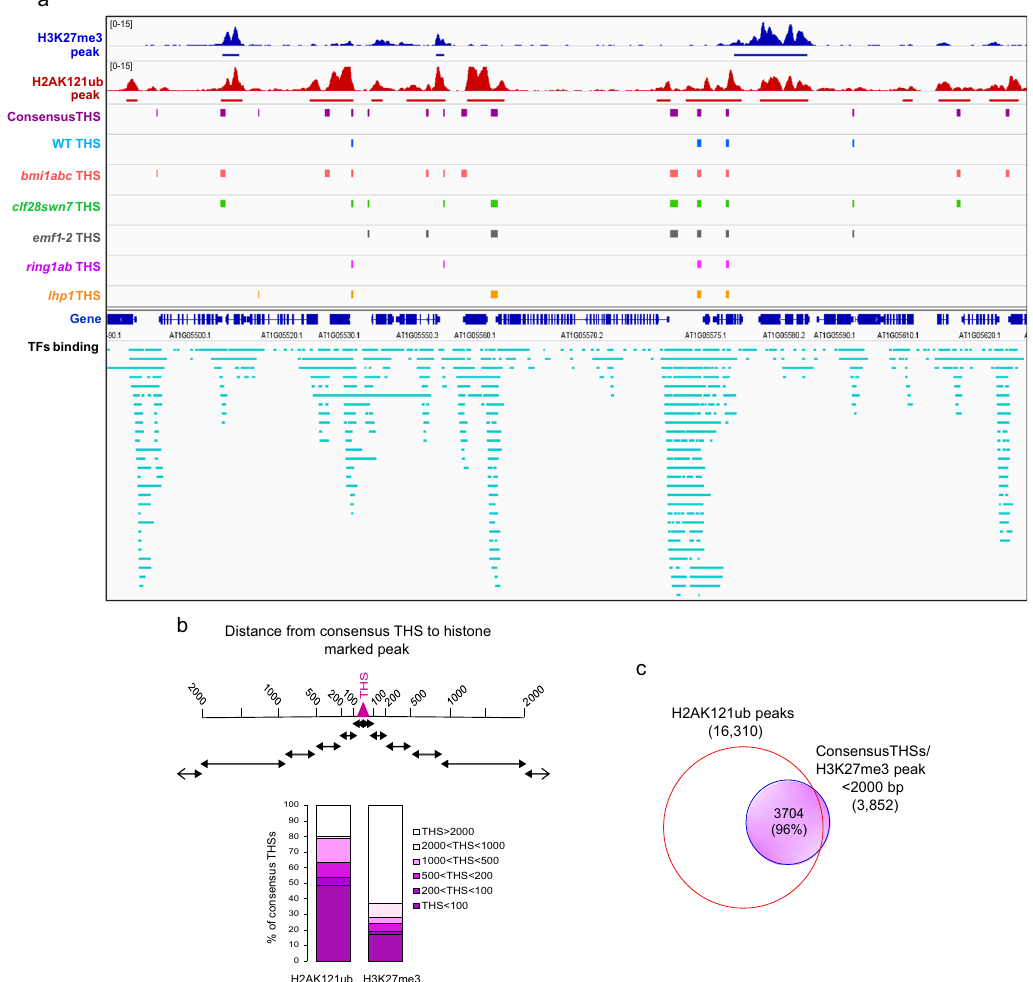
Fig. 2 H2AK121 monoubiquitination hallmarks hotspots for transcriptional regulation. a Screenshots showing distribution of H3K27me3 and H2AK121ub peaks in WT, consensus THSs, genotype-speci fi c THSs, and TFs binding sites. H3K27me3 and H2AK121ub peaks are indicated in blue and red, respectively. Consensus THSs, genotype-speci fi c THSs, gene regions, and TFs binding sites color code is as in Fig. 1f. b Percentage of consensus THSs showing an H2AK121ub or H3K27me3 region at different non-overlapping distance intervals as indicated. c Venn diagram showing the overlap between consensus THSs having an H3K27me3 peak within the next 2 kb and H2AK121ub